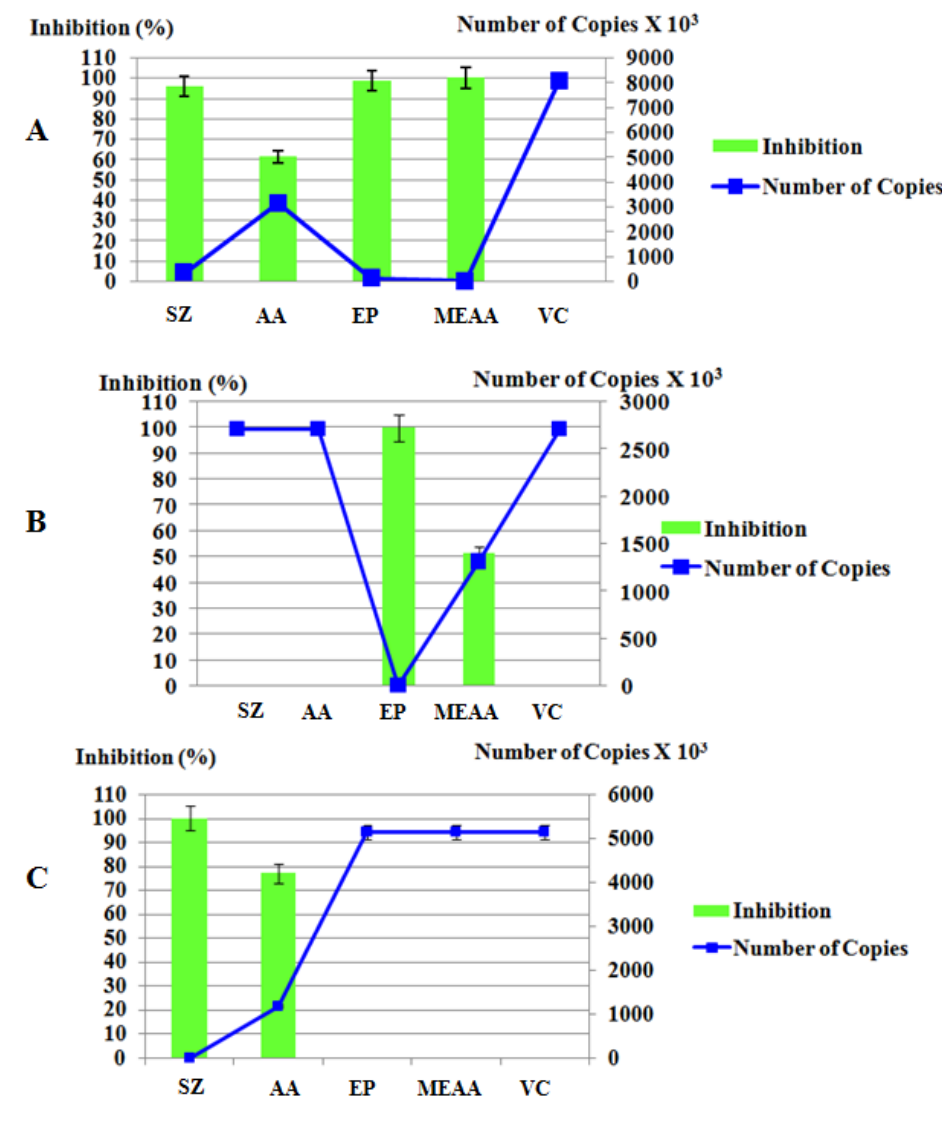
Figure 4. Correlation between viral genome equivalents and percentage of inhibition during different stages of viral replication. ( A ) Virucidal activity; ( B ) Penetration activity; (C)